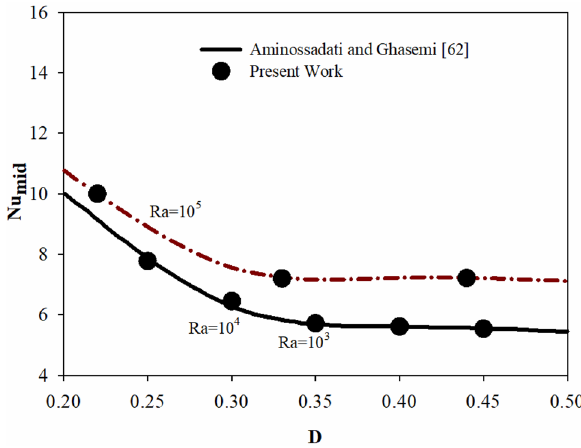
Figure 3. Average Nu obtained by present work compared that from Aminossadati and Ghasemi 62